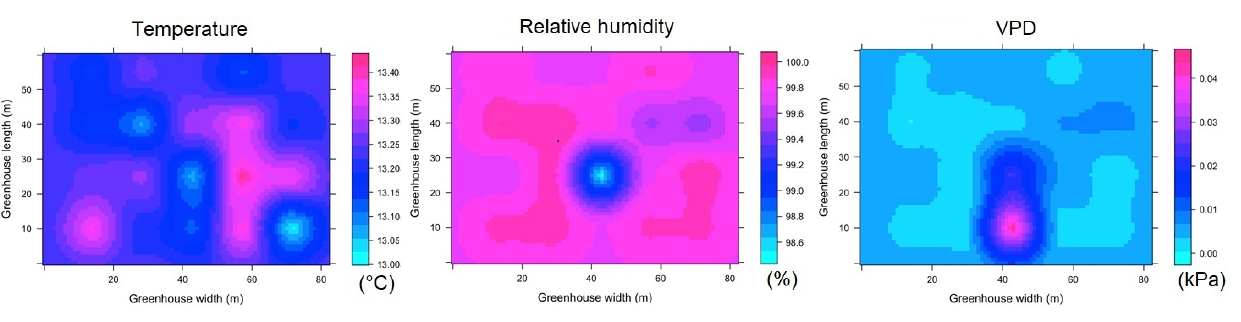
Figure 14. Spatial distribution predicted by kriging, for temperature, relative humidity and VPD in HGT1 and for ESRL 5.